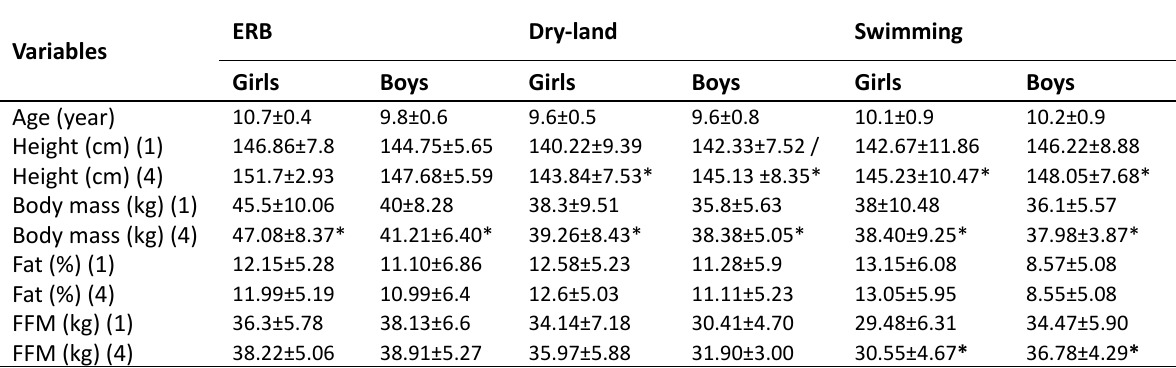
Table 2. The subject characteristics according to the